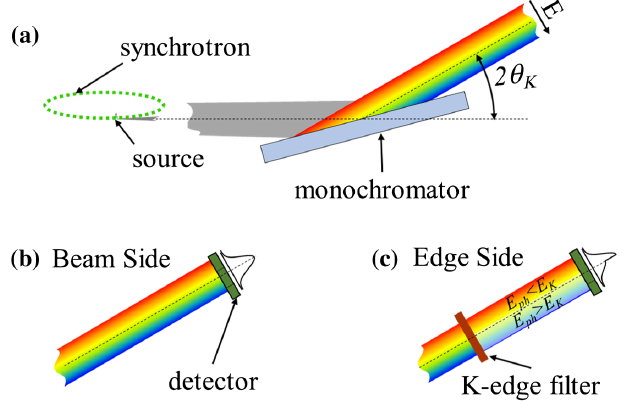
FIG. 1. Schematic of the ps-BPM system containing (a) the crystalmonochromator,the K -edgefilter,andthedetector.Asingle- crystal Bragg geometry is shown. (b) and (c) show the unfiltered beam size and the filtered edge side of the beam, respectively.